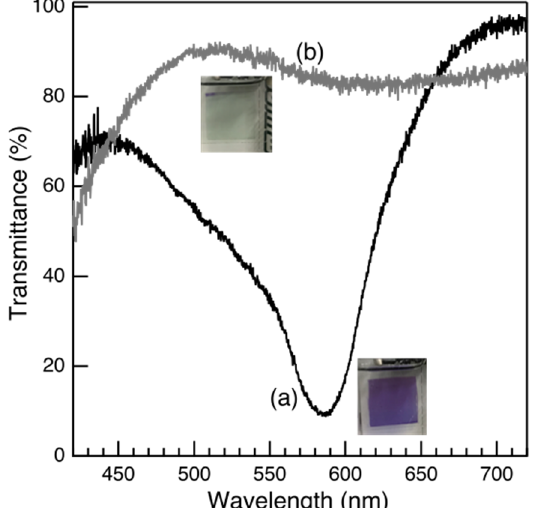
Figure 6. Transmittance spectra recorded on an Ocean Optics modular spectrometer for polyFe/LIIm composite-3/0.1 film spin coated on ITO glass (1.5 × 1.5 cm) ( a ) before (color state) and ( b ) after oxidation (bleached state) upon applying 1.2 V vs. Ag/Ag + by chronoamperometry on VersaSTAT4 in the three-electrode system with a spring-type Pt wire as a counter electrode and Ag/Ag + as a reference electrode in 0.1 M LiClO 4 of anhydrous acetonitrile solution as an electrolyte solution. Inset: the photographs.